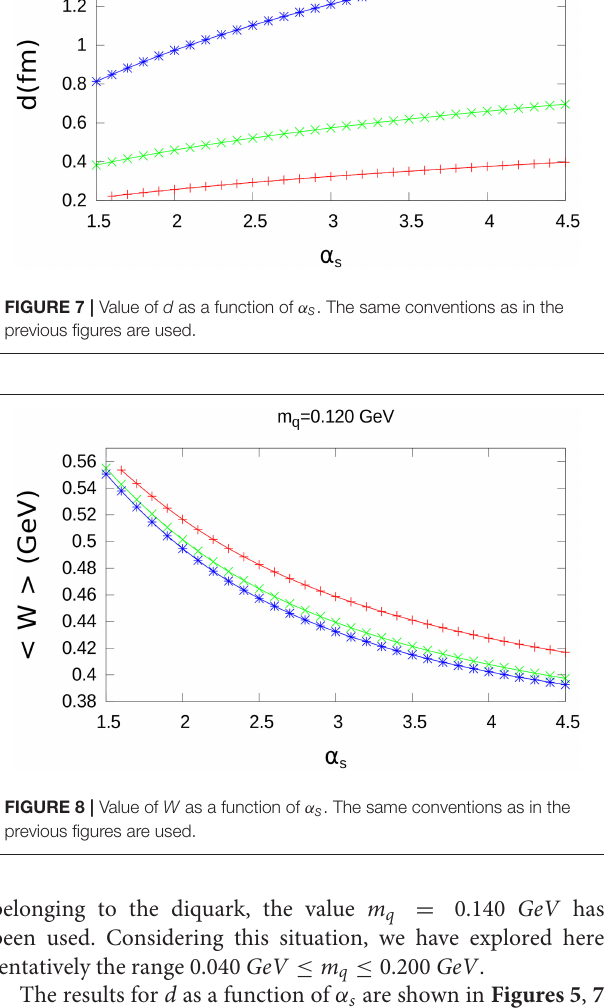
belonging to the diquark, the value m q